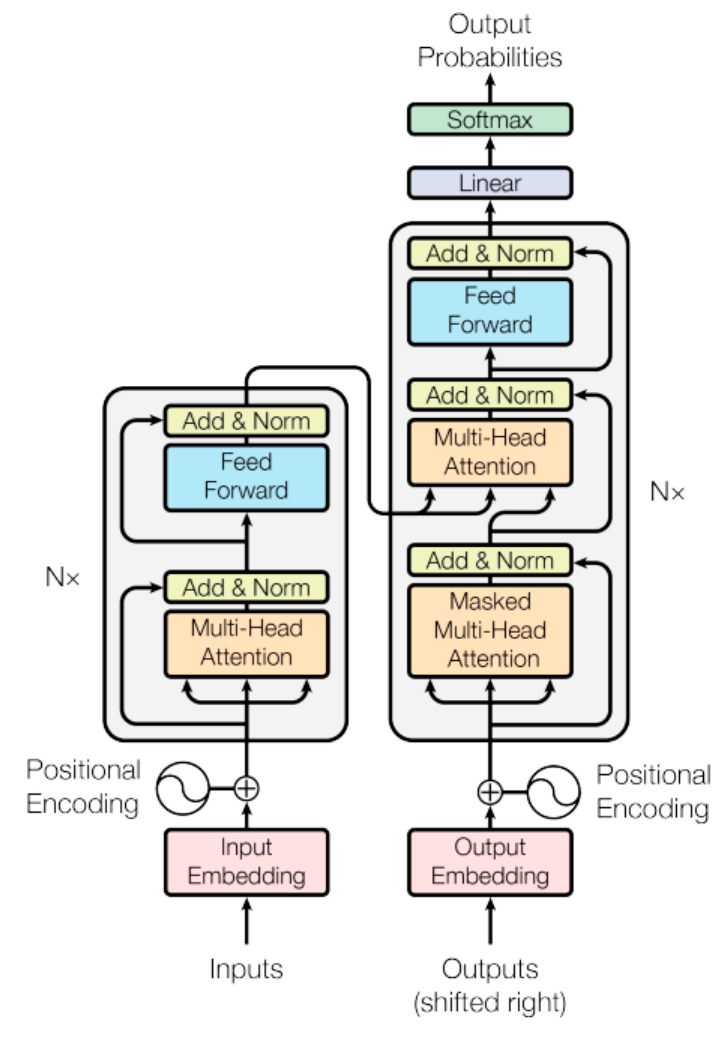
Figure 25. The general architecture of transformers [65].